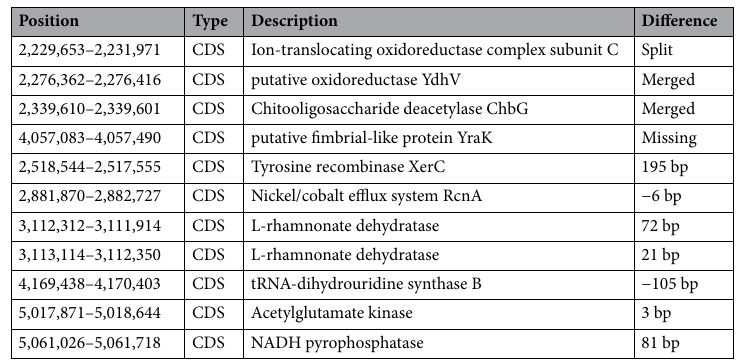
Table 5. Differences between PEPPER × Homopolish and PEPPER × Homopolish × Pilon. 7 predicted hypothetical proteins, not match between two polished assemblies are not listed.